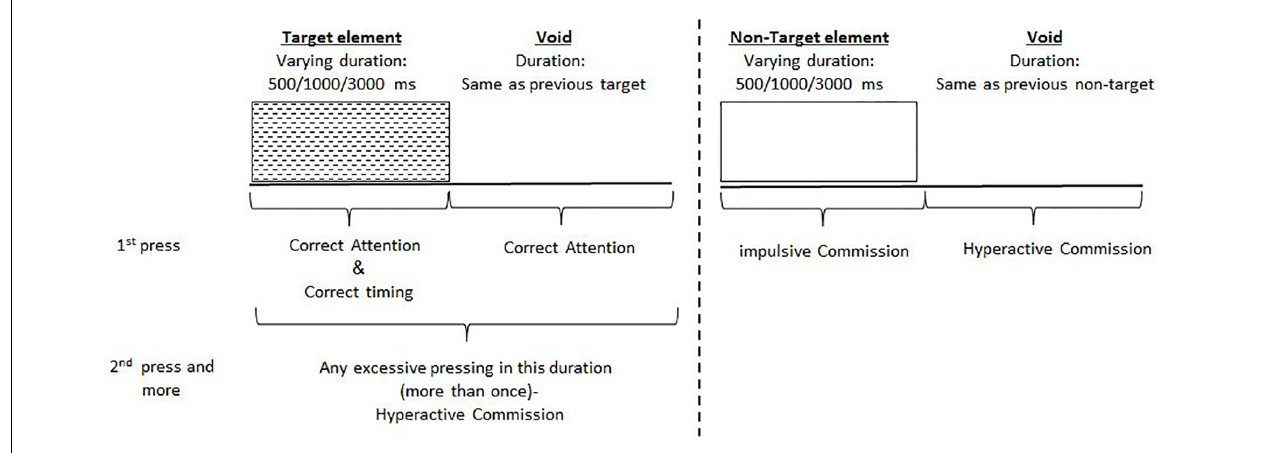
FIGURE 1 | Definition of the timeline. Target and non-target stimuli were presented for 500, 1,000 or 3,000 ms. Each stimulus was followed by a void period of the same duration. The stimulus remained on the screen for the full duration regardless of the response. Distracting stimuli were not synchronized